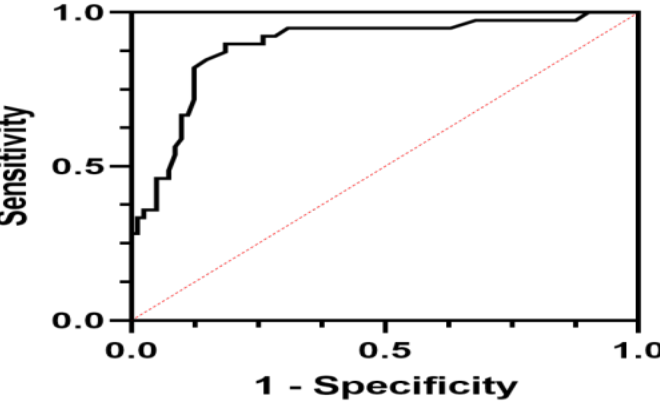
Figure 8. ROC curve of the accident prediction of the Bayesian network model.